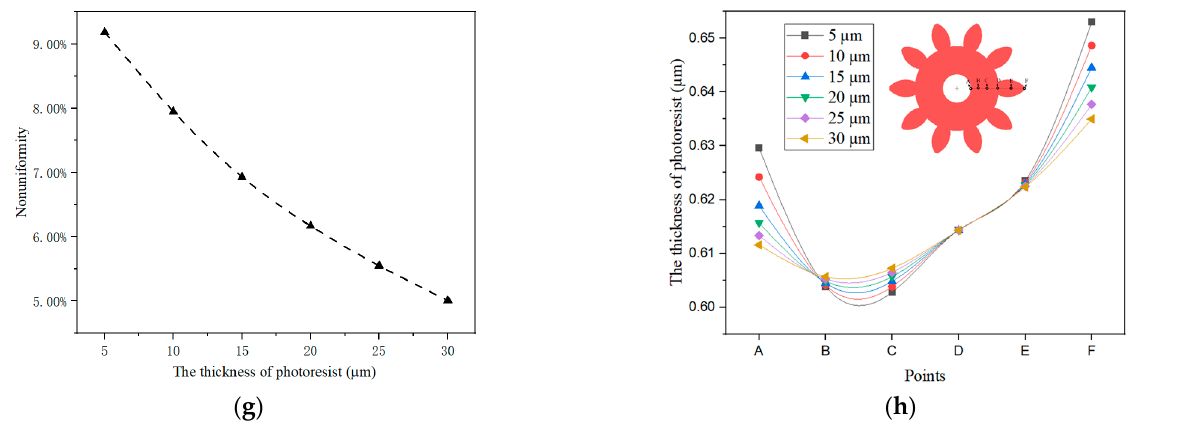
Figure 4. Simulation results and calculated results of thickness distributions with different thicknesses of the photoresist. ( a ) TP = 5 µm; ( b ) TP = 10 µm; ( c ) TP = 15 µm; ( d ) TP = 20 µm; ( e ) TP = 25 µm; ( f ) TP = 30 µm; ( g ) Calculated nonuniformity for different TPs; ( h ) thickness distribution curves of location points (A, B, C, D, E and F) for different TPs. Table 2. Difference of α by TP.